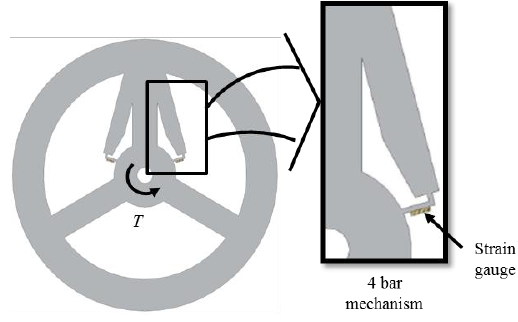
Figure 4. Torque sensor with high sensitivity (TSHS).